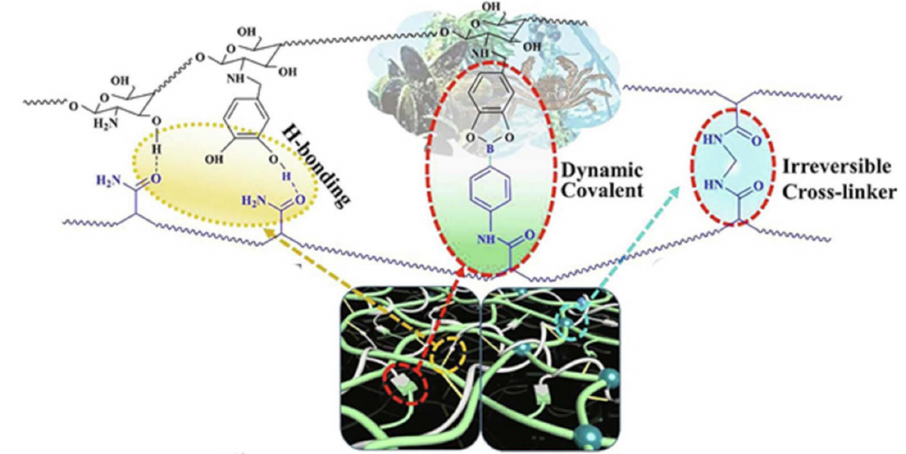
Figure 48. H-bond, dynamic covalent bonds and chemical cross-linkers in the cross-linking networks of chitosan containing catechol groups (black) and PAM (blue). Reproduced from [216] with permission from